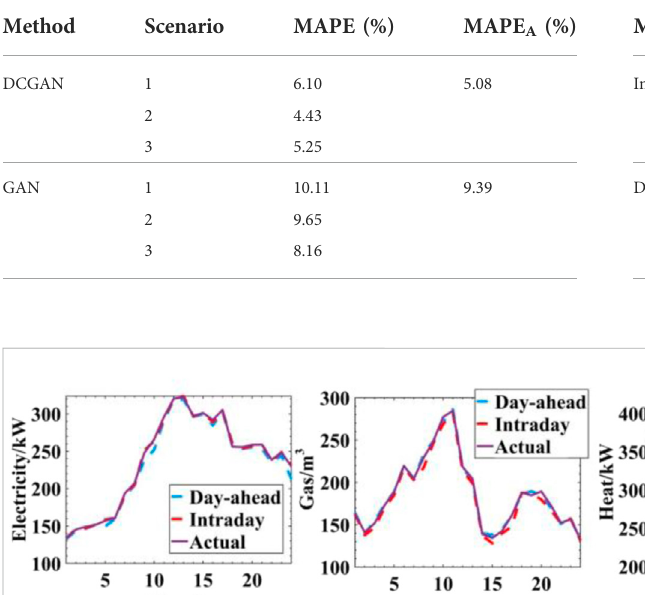
TABLE 5 Prediction errors for scenario generations in the day-ahead stage using DCGAN, GAN.